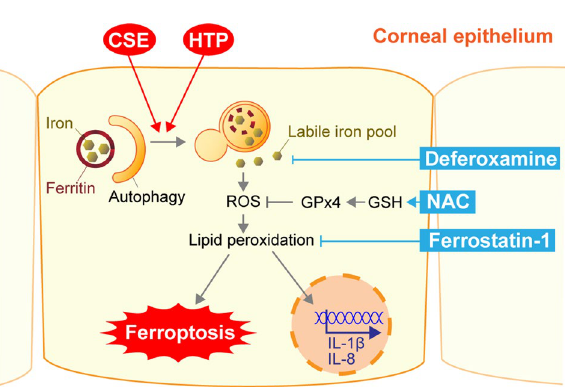
Figure 7. A graphical summary of the results presented in this